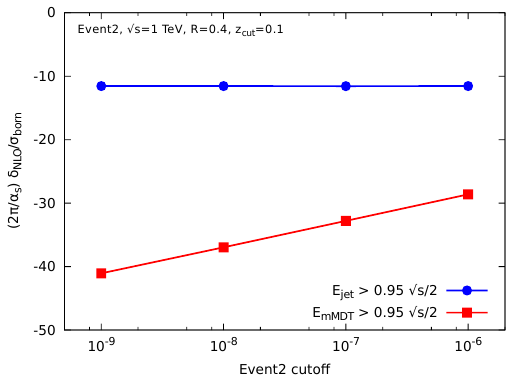
Figure 5 . Dependence of the jet cross-section before and after applying mMDT, as a function of the infrared cut-o(cid:11) used in EVENT2 . The cross-section before grooming is stable but the one after grooming diverges logarithmically, thus making IRC unsafety apparent.